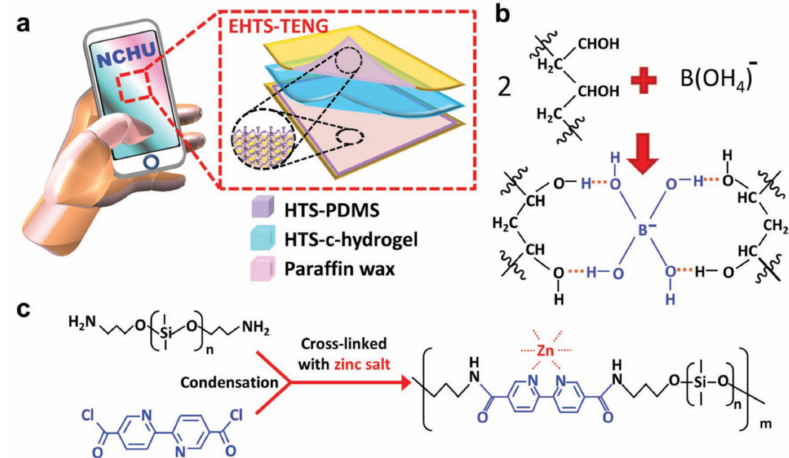
Figure 54. ( a ) Applications and exploded view of TENG. Reactions to form of ( b ) HTS-c-hydrogel and ( c ) HTS-PDMS. EHTS is fully self-healable, transparent and stretchable. Reproduced from [40] with permission from John Wiley and Sons.